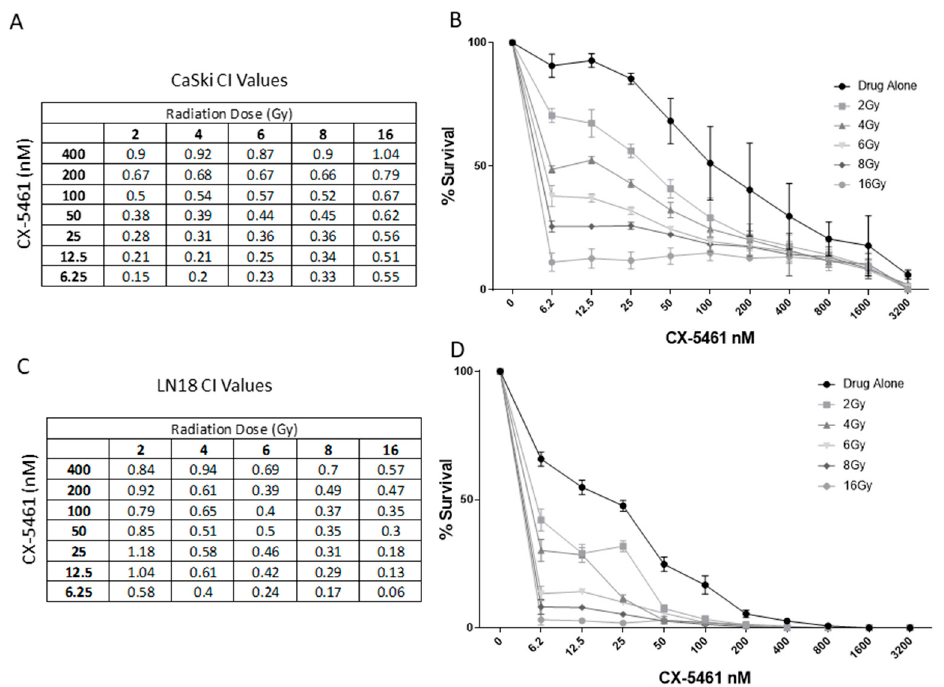
Figure 2. The cytotoxic activity of CX-5461 is enhanced when combined with single-dose X-rays. Combination index values obtained through isobologram analysis for CaSki cell line ( A and B ) and LN18 cell line ( C and D ) following combination treatments involving CX-5461 and single-dose X-ray exposure (2, 4, 6, 8 and 16 Gy). CI values < 1 were considered synergistic and CI values > 1 were considered antagonistic.